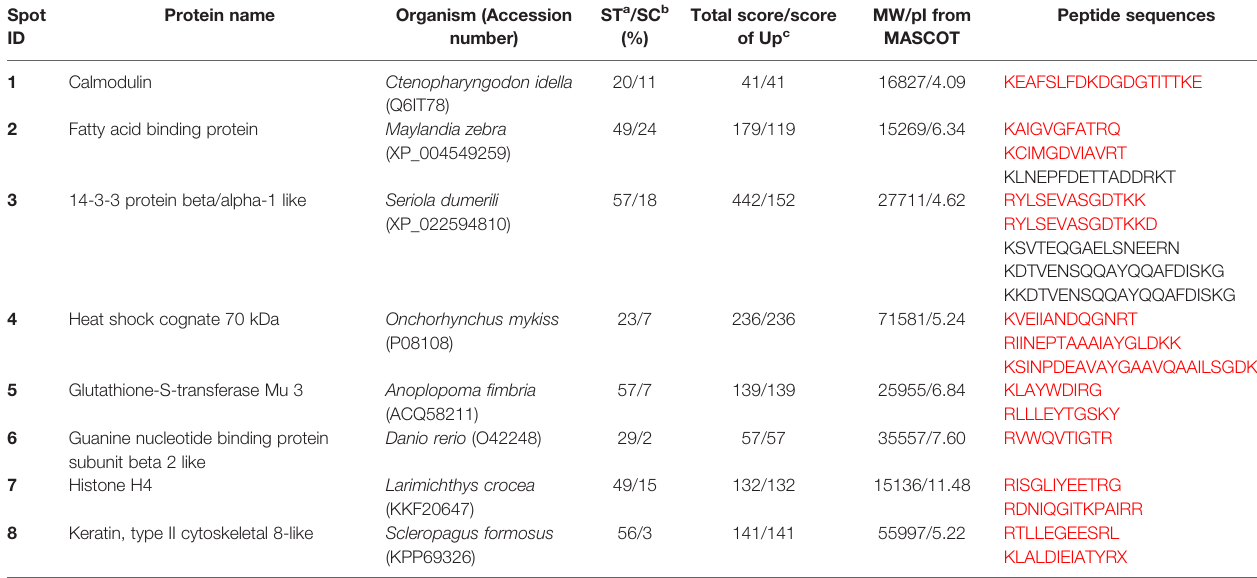
TABLE 3 | Differentially expressed proteins from skin of lump fi sh under crowding stress.